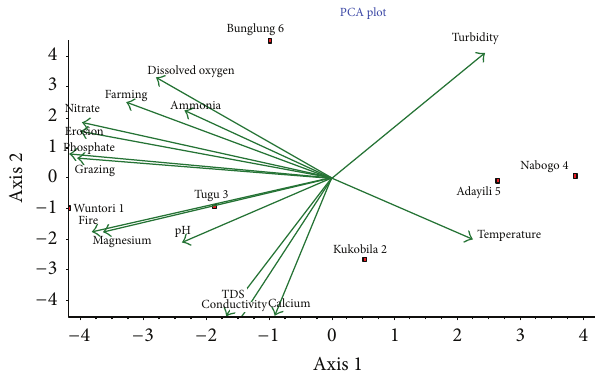
Figure 6: Principal component analysis (PCA) diagram, showing the significant correlations ( 𝑝 < 0.05 ) of environmental factors on fish community structure community and diversity in the six sites. The red squares represent the wetlands, while the arrows represent each of the environmental factors plotted pointing in the direction of maximum change of explanatory variables on a longitudinal gradient of the six sites. Axes 1 = 49.06% and Axes 2 = 32.77% jointly explained 81.83% influence of environmental variables on community structure, distribution, and